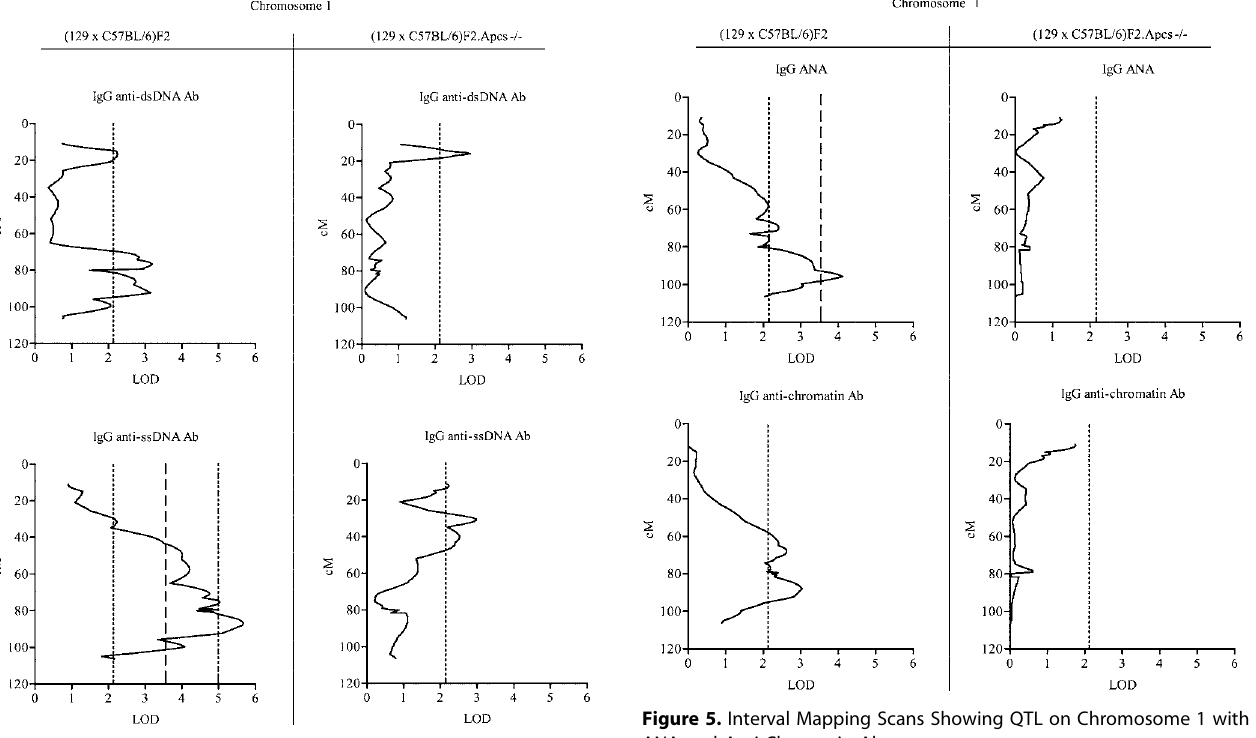
Figure 4. Interval Mapping Scans Showing QTL on Chromosome 1 with Anti-dsDNA and Anti-ssDNA Abs Centimorgan positions were deduced by interval mapping, anchoring marker locations to data from http://www.informatics.jax.org. Dotted lines indicate the threshold over which linkage was considered suggestive, dashed lines indicate the threshold over which linkage was considered significant, and dotted/dashed lines indicate highly significant linkage, as defined in Materials and Methods. See Table 3 for additional details. DOI: 10.1371/journal.pbio.0020243.g004